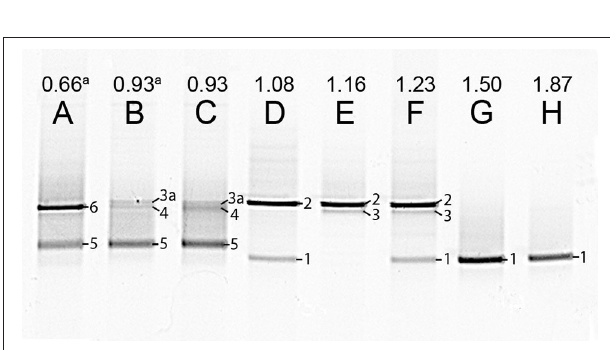
FIGURE 3 | Photograph of DGGE gel with the PCR products of the 16S rRNA genes from steady state reactor samples, with different Ac/N ratios (cropped; no other bands were present in the lanes). The numbers on the right side of the bands correspond to the markers in Table 5 . Bands labeled with the same number, contained the same sequence. Note that for the culture in lane A denitrification is dominant and in H DNRA is. The unprocessed DGGE photo is included in Figure S2. (a) The influent was supplemented with 1.4mM